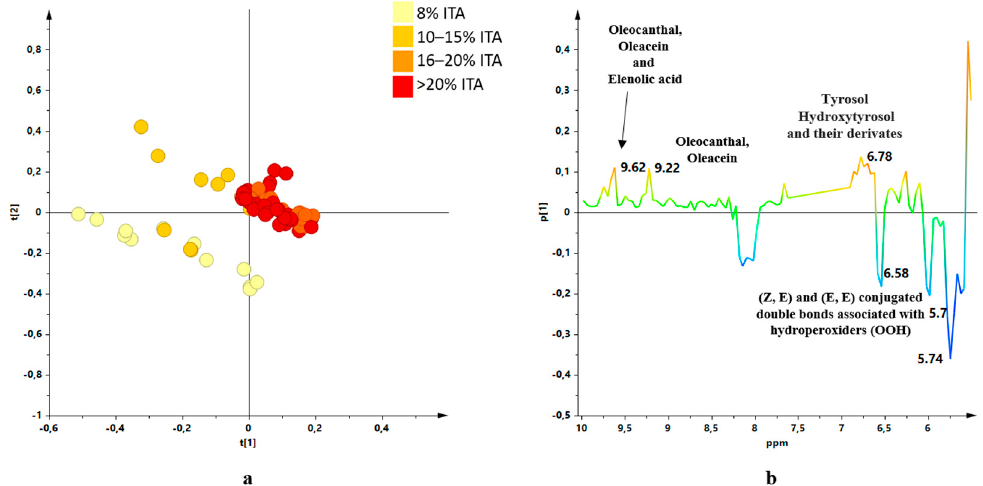
Figure 5. ( a ) Score plot of the PCA model of 1 H-NMR multi-suppressed experiment data for samples of considered organic EU community and non-community oils; 3 components model with R 2 X = 0.730, Q 2 = 0.610. ( b ) S-line plot for the Figure 5a PCA model.